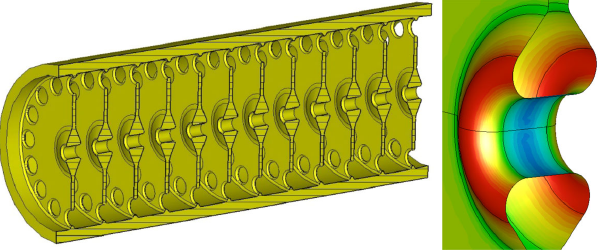
FIG. 7. BTW structure model (left) and electric field distribu- tion in the nose part for the 50 MV = m gradient (right). Red color corresponds to 200 MV = m. FIG. 8. The dispersion curve of disk-loaded periodic wave- guide structures with a magnetic coupling ( n ¼ 0 curve corre- sponds to the fundamental harmonic, n ¼ − 1 curve corresponds to the first negative